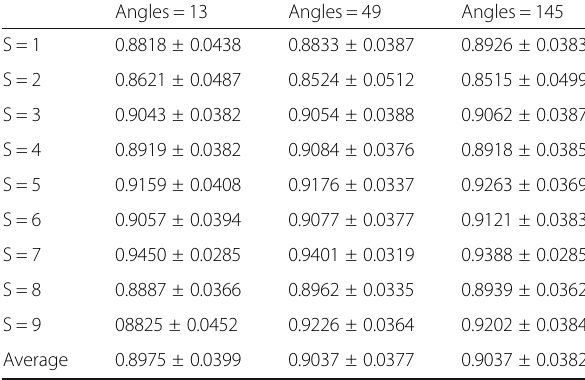
Table 7 AUC scores of LMA without duplicate angles over 100 training and testing